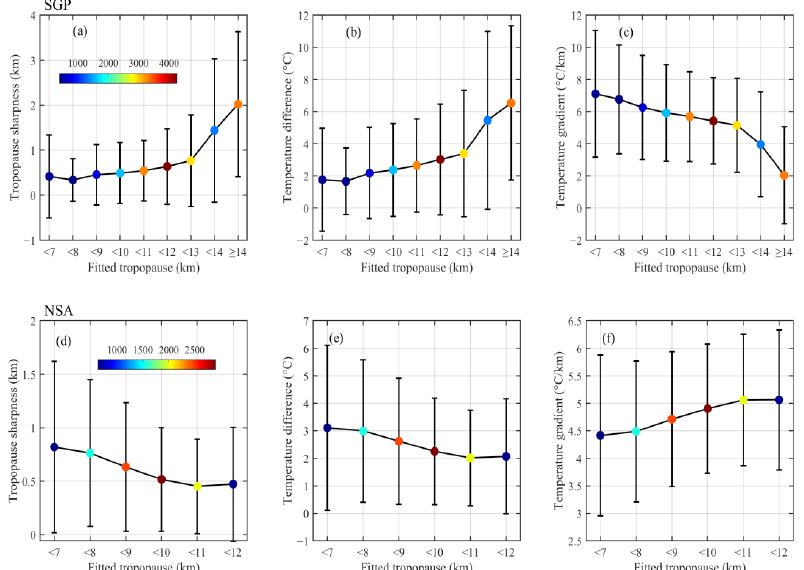
Figure 9. Average values and standard deviation of the tropopause sharpness ( a ), temperature difference ( b ), and temperature gradient ( c ) as a function of the fitted tropopause height at SGP; panels ( d – f ) are similar to ( a – c ) but at NSA. The color bar shows the number of data points in each bin off by 1 km on the x -axis (for example, <10 on the x -axis denotes the fitted tropopause height between 9 and 10 km).